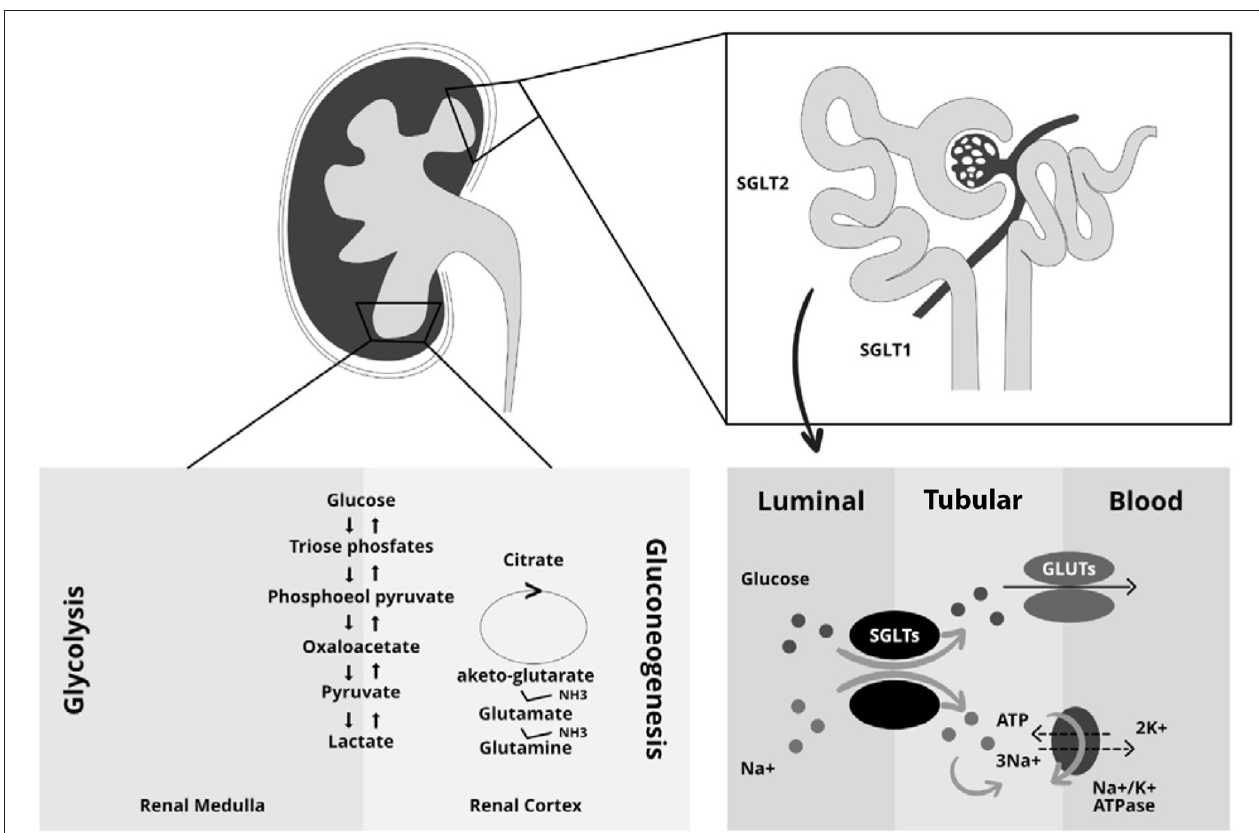
FIGURE 2 | Central role of the kidney in glucose metabolism. The kidneys intervene in glucose homeostasis regulation through three main mechanisms: the glucose reabsorption via sodium co-transporters (SGLTs), the gluconeogenesis with endogenous glucose production and the utilization of glucose. The right side of the figure shows the mechanism of sodium and glucose reabsorption through the SGLT and GLUT transporters in the kidney. SGLTs, which are mainly located on the brush border (luminal side) of epithelial tubular cells, enables the transfer of both sodium and glucose from the lumen into the tubular cells. Sodium is transported along with glucose through the SGLTs. Next, glucose enters blood circulation through an active transport mechanism mediated by GLUTs, which are located on the basolateral membrane of the epithelial tubular cells. Sodium is actively exchanged between tubular cells and blood circulation through a Na + /K + /ATPase pump. The different phases of renal gluconeogenesis and glycolysis are depicted on the left side of the figure.